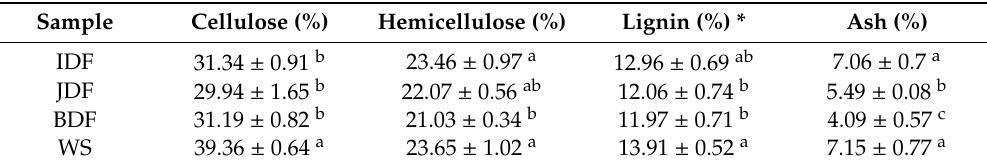
Table 5. Lignocellulosic content of di ff erent animal dung fibers and wheat straw.